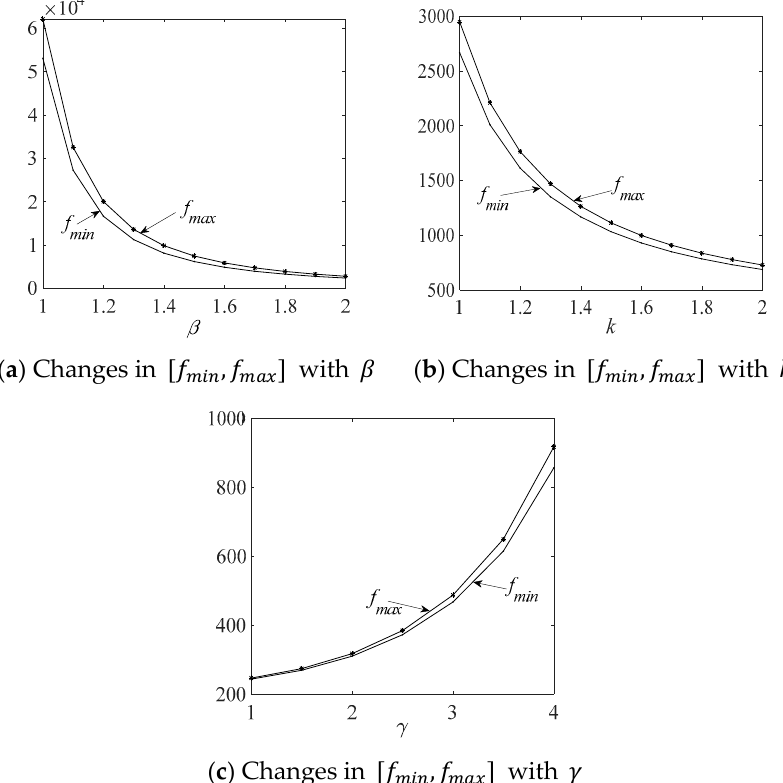
Figure 6. Changes in [ f min , f max ] with parameters. Table 4. Parameter values and change rates before and after